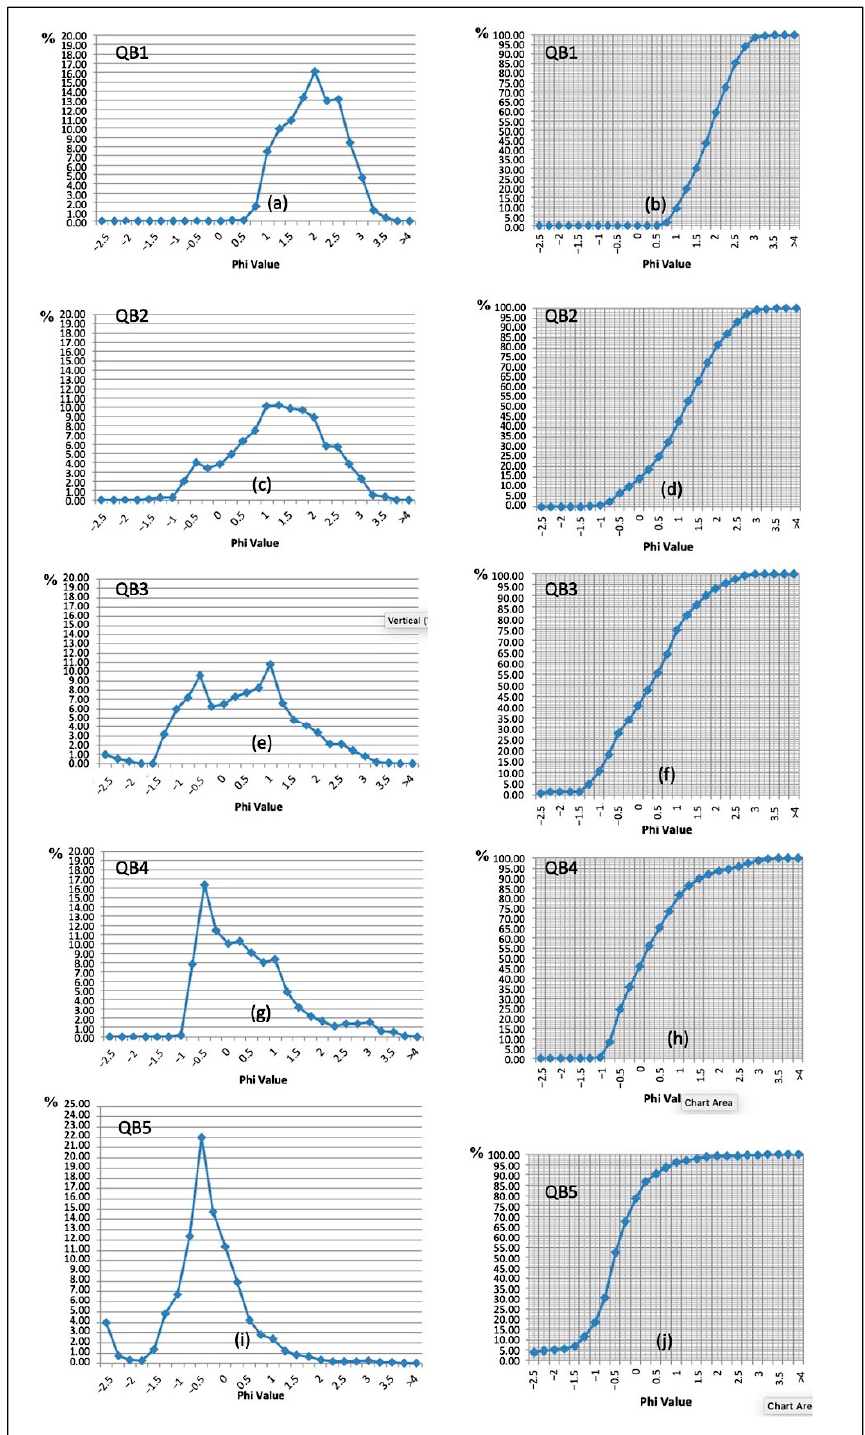
Figure 9. The Persiaran Bayan Indah (the Queensbay Mall) samples’ grain size distribution trend is shown in the figures labeled as ( a , c , e , g ), and ( i ). The grain sample’s cumulative frequency is shown in the figures labeled as ( b , d , f , h ), and ( j )—these five samples, QB1 to QB5, representing the dumping sediment along the anthropogenic coastal landform coastline.